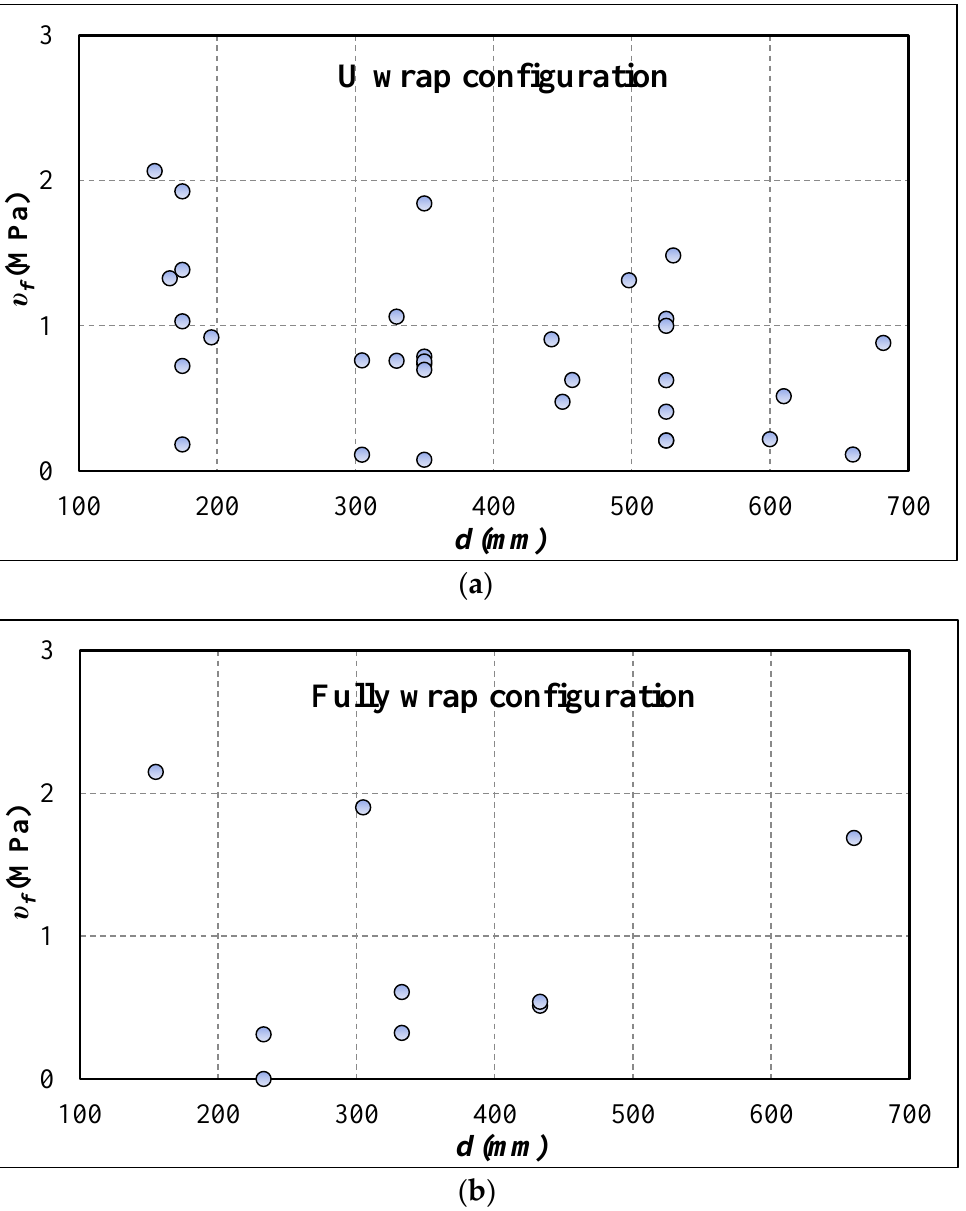
Figure 7. Size effect influences of shear-strengthened RC beams: ( a ) U-wrap configuration; ( b ) full-wrap configuration.